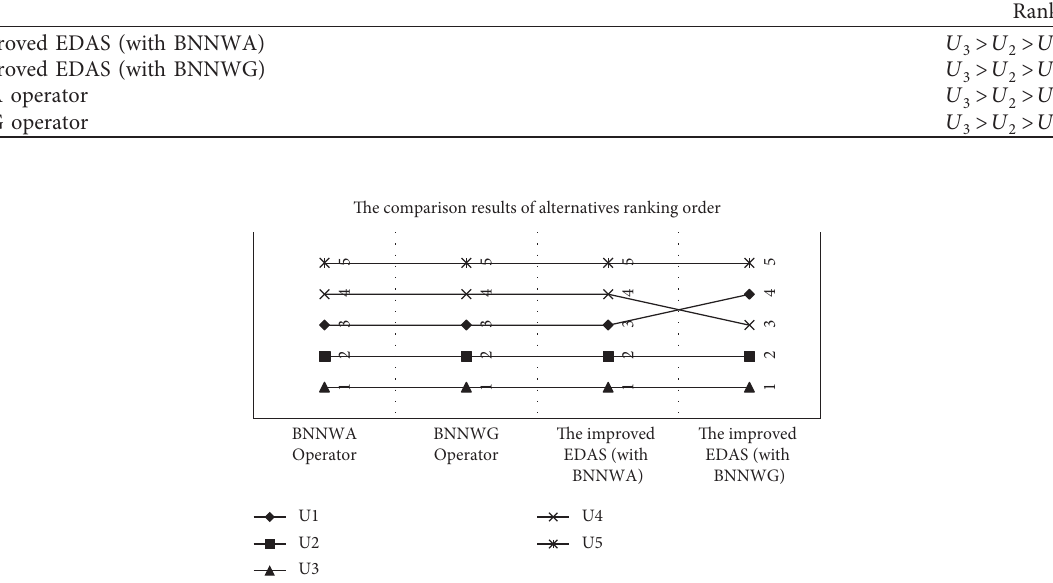
Figure 2: The comparison results in terms of alternatives ranking order using φ � 0 . 5.